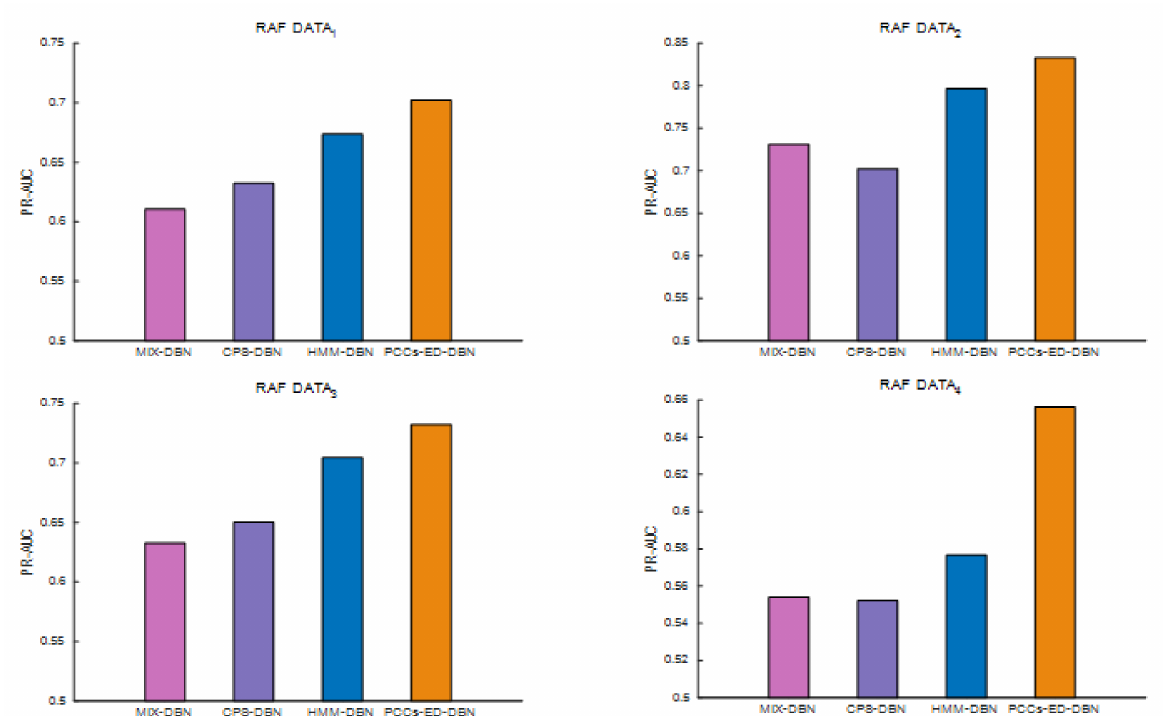
Figure 13. Accuracy comparison of different models on four RAF pathway datasets.